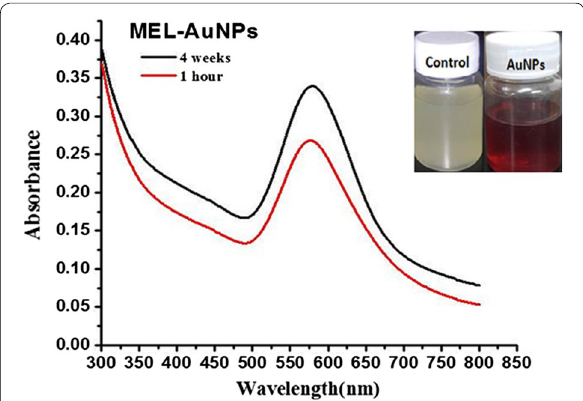
Fig. 2 UV–Vis spectra of biosynthesized MEL-AuNPs using